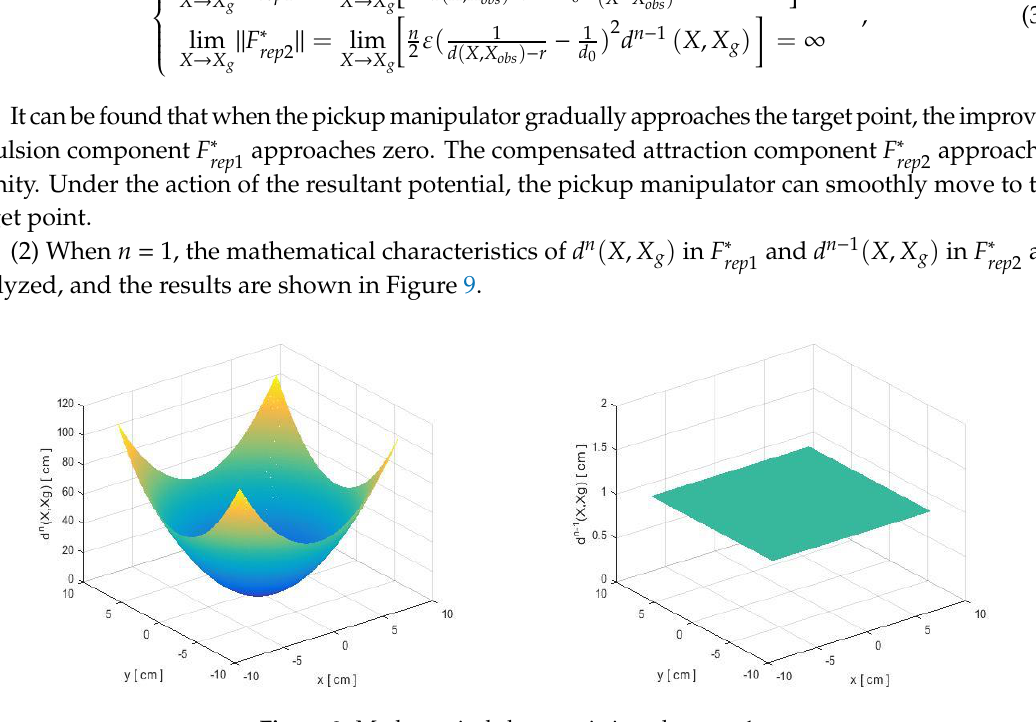
Figure 9. Mathematical characteristics when n = 1.